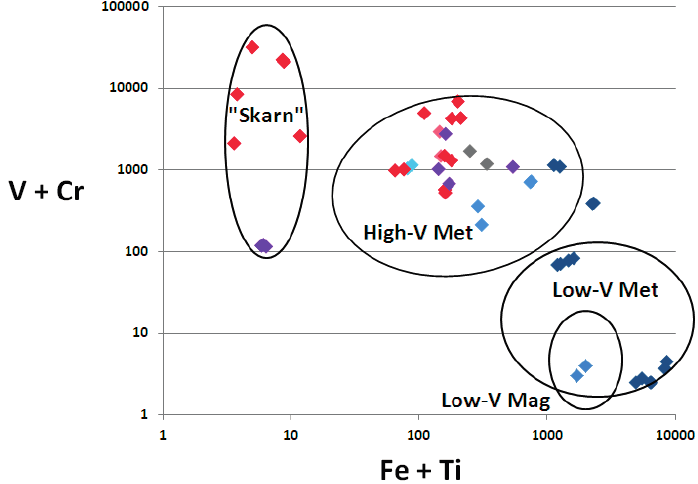
Figure 5. V + Cr − Fe + Ti plots, for Mogok corundum fields. Met metamorphic, Mag magmatic, “Skarn” Si-Ca-Ga-rich